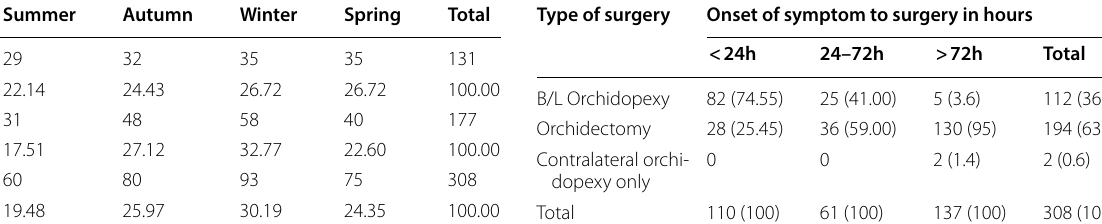
Table 3 Season of the year and age groups